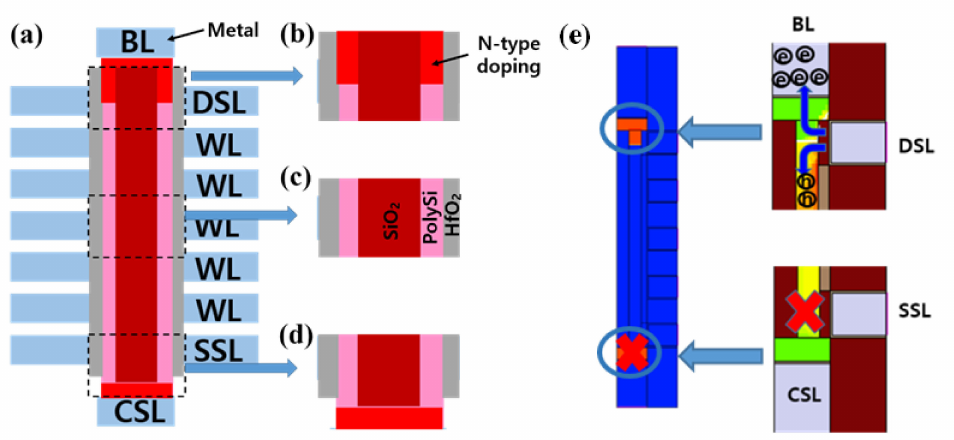
Figure 2. Description of V-NAND structure of ferroelectric memory using Gate Induce Drain Leakage (GIDL) phenomenon. ( a ) shows the overall structure, ( b ) is a drain select line (DSL) transistor structure with an over-doped region for generating the GIDL phenomenon, ( c ) shows the word lines (WLs) region and ( d ) shows a Source Select Line (SSL) region without an over-doped region. Finally, ( e ) shows the movement of electrons and holes in the proposed GIDL program operation method.